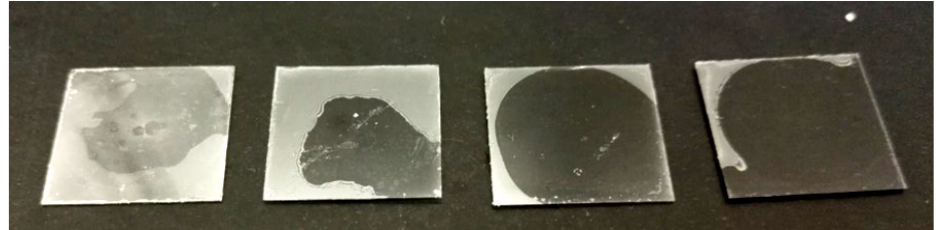
Figure 22. Image shows 1000 rpm samples of resin and composite material inverted. The lighter regions correspond to the aqueous solution that has infiltrated the sample/glass substrate interface.